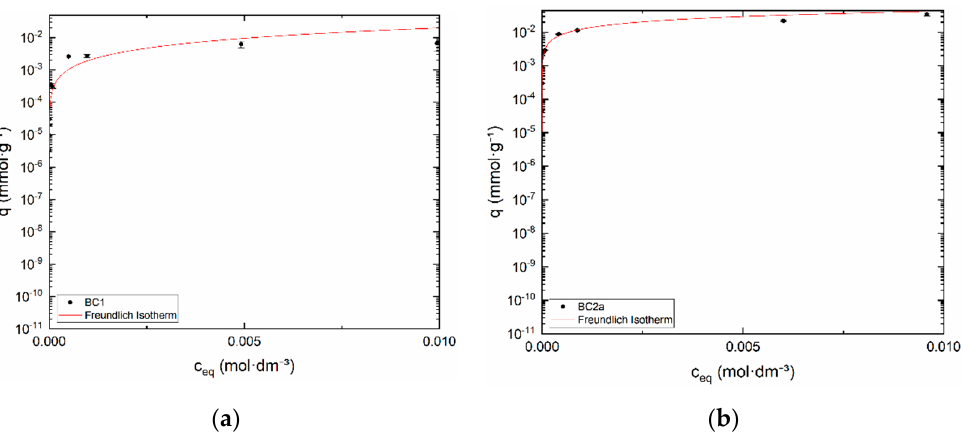
Figure 6. Dependence of sorption percentage ( R ) on contact time ( t ). BC1 pH = 4, BC2a pH = 2.